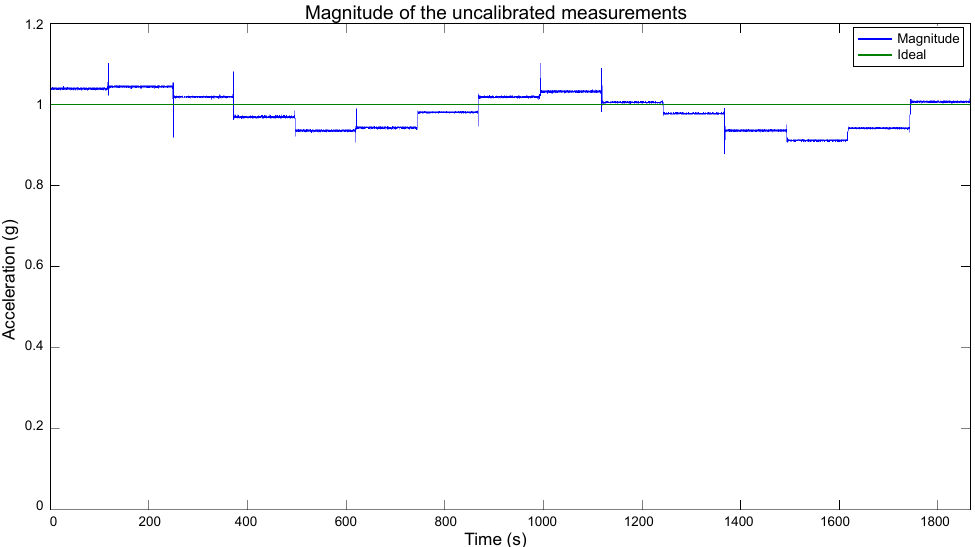
Figure 6. Magnitude of the acceleration measurements of the FXOS8700CQ sensor.